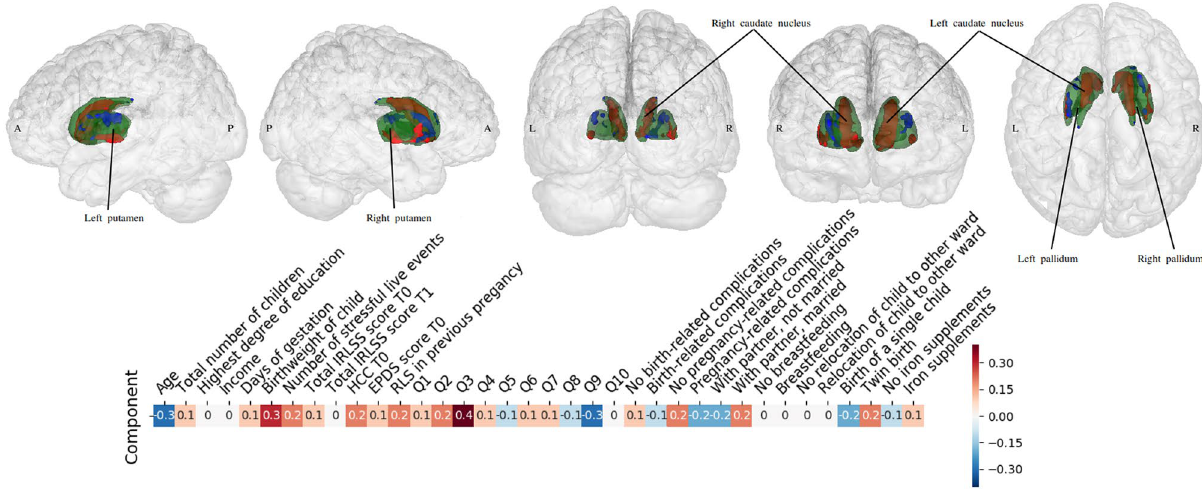
Figure 3. Specific patterns linking the basal ganglia to the phenotypical predictors of RLS. * IRLSS score T0 = Severity of RLS symptoms in pregnancy; IRLSS score T1 = Severity of RLS symptoms 12 weeks postpartum. A targeted post-hoc CCA was applied to find coherent associations between the basal ganglia volume changes and changes in the patients’ anamnestic and clinical indicators. While the above-mentioned analysis (Fig. 1) considered the whole brain as measured by volume estimates, the present analysis focused on the left and right basal ganglia at a more fine-grained voxel resolution. Green indicates the anatomy of the target regions as part of the basal ganglia. In the top row, the loadings of the basal ganglia voxels are plotted from the left, right, posterior, anterior and superior views. The green area contours expose the outer shape of the basal ganglia voxels, which cover the striatum (putamen and caudate nucleus) and the pallidum. Within the basal ganglia, the blue area indicates negative CCA loadings associated with those specific voxels while the red indicates positive CCA loadings for those specific voxels. The bottom row depicts the loadings of the patient’s behavioral and clinical indicators (blue for negative and red for positive). While having a baby with higher birth weight